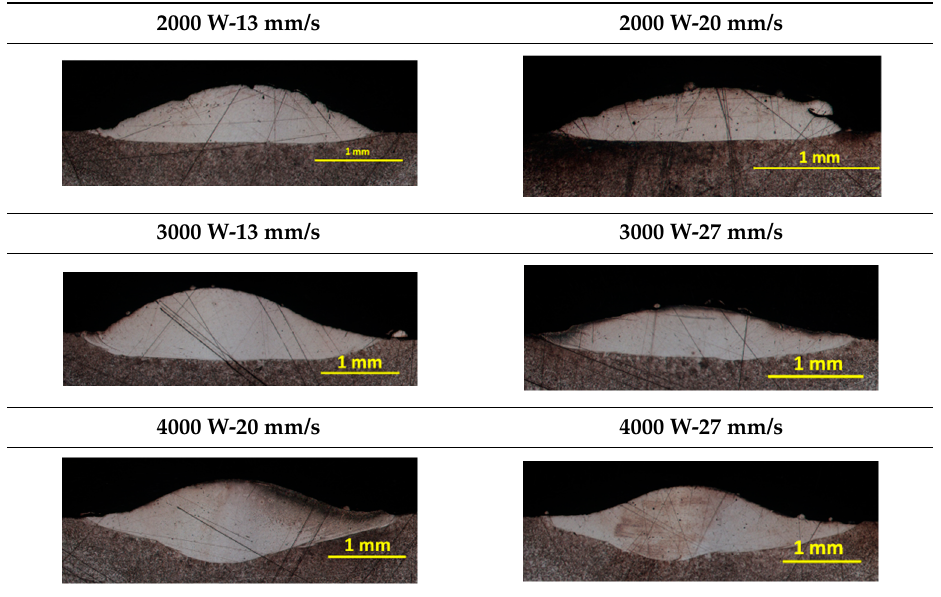
Table 3. Experiments with powder flow of 12 g/min.